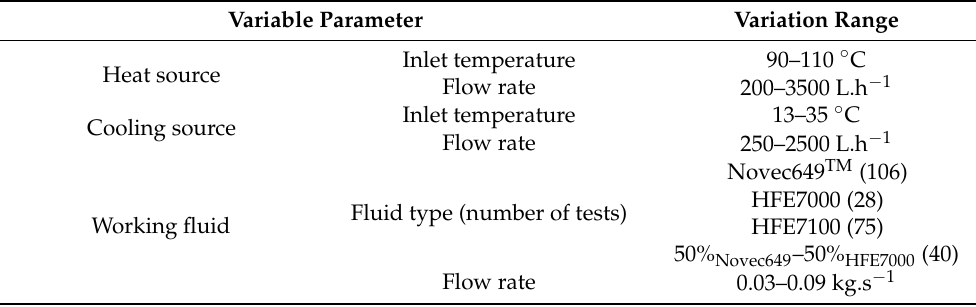
Table 4. Variable parameter and variable range (campaign